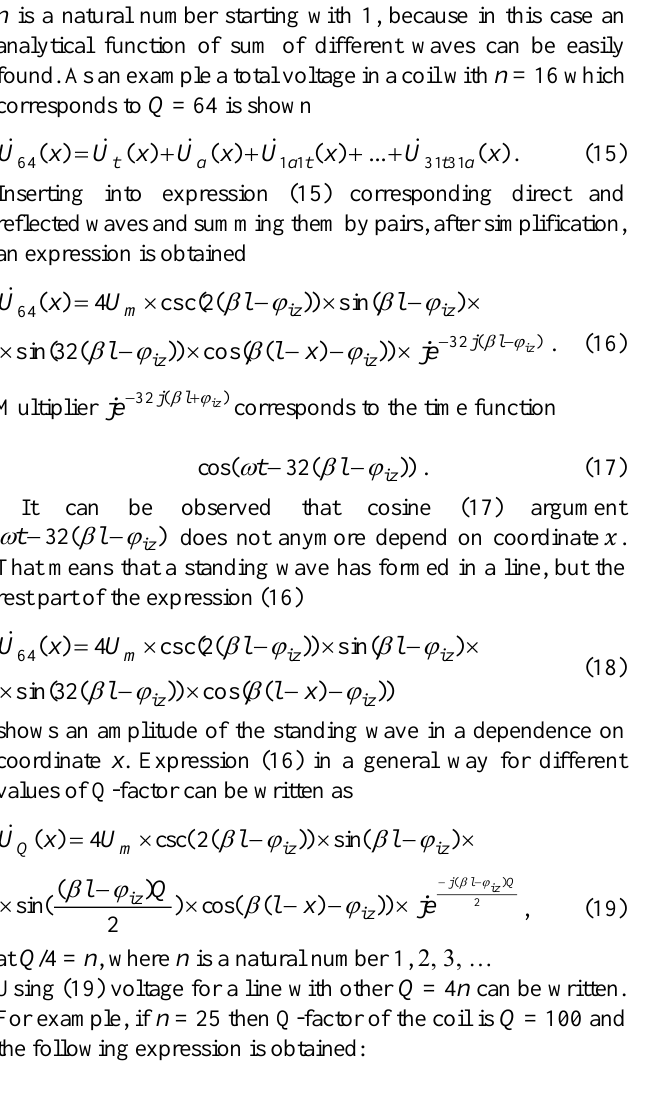
Fig. 8. Tesla coil amplitude-frequency